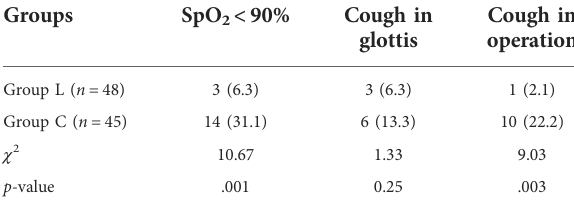
TABLE 4 Comparison of adverse event incidence between the two groups [case (%)].